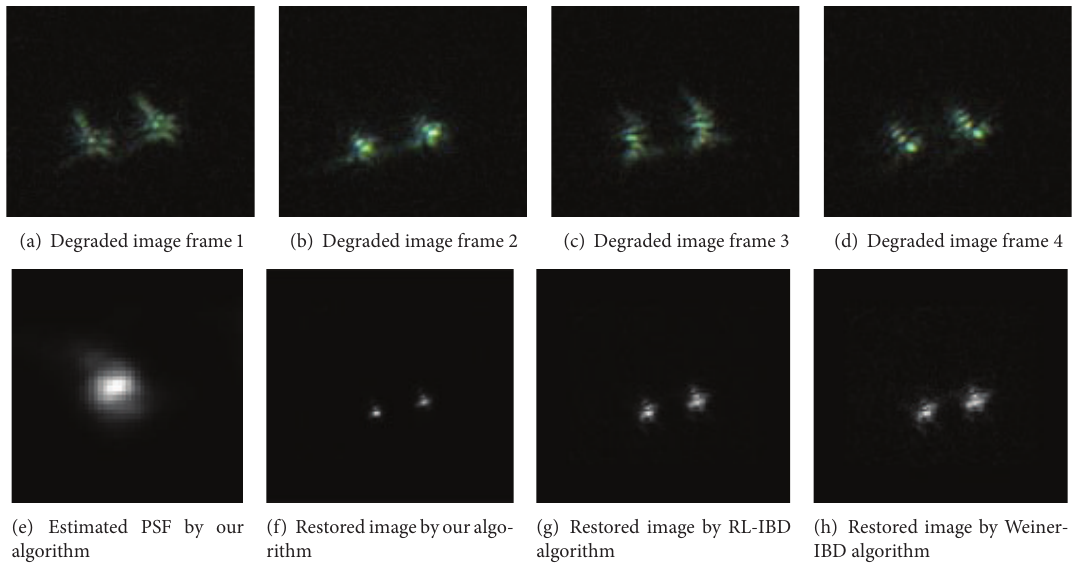
Figure 3: Multiframe original images and restoration comparison of three